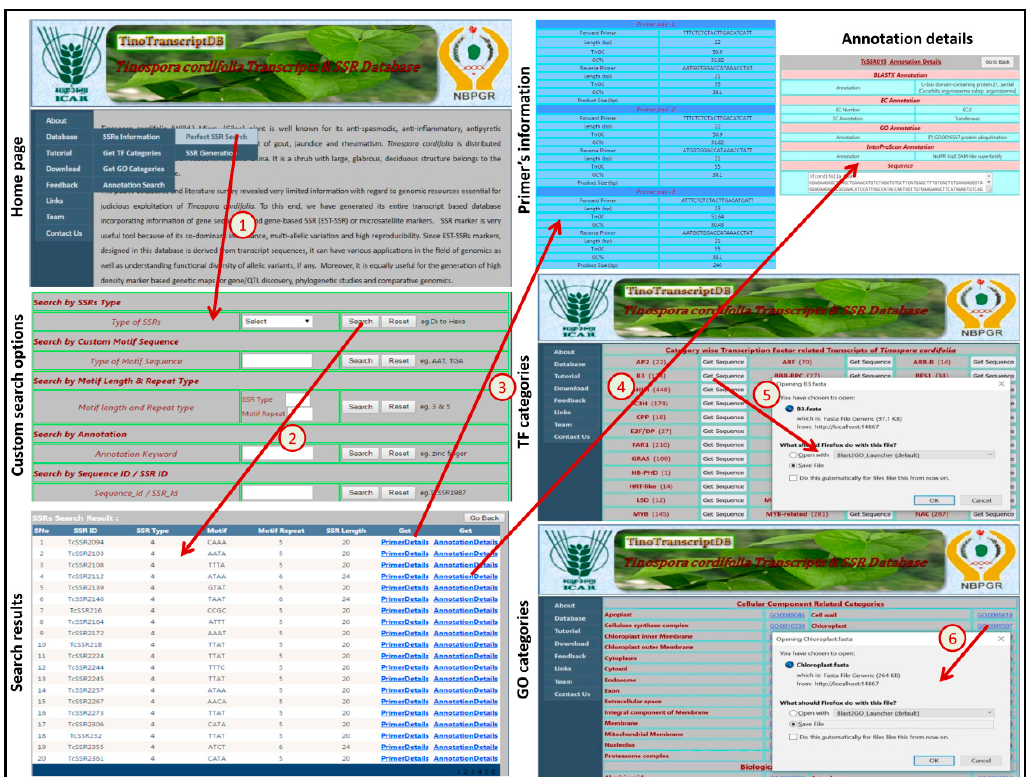
Figure 6. Screenshot of the TinoTranscriptDB showing SSR and primer searching using different search options, (1) arrow shows perfect SSR search criteria on SSR search page; (2) arrow shows search for SSR di to hexa types; (3) arrow shows Primer Details link of particular SSR; (4) arrow shows Annotation Details link of particular SSR with annotation information; (5) arrow shows Sequences link of that TF category in a fasta sequence file; (6) arrow shows GO Id in fasta sequence file.